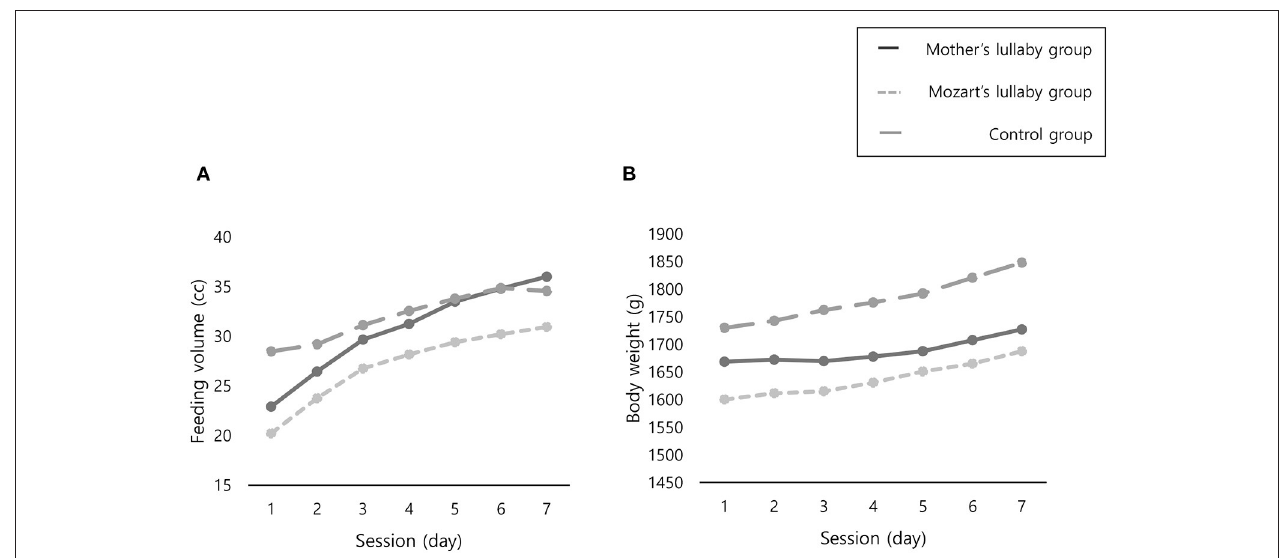
FIGURE 3 | Comparison of changes in feeding volume and body weight between three groups. (A) Feeding volume. (B) Body